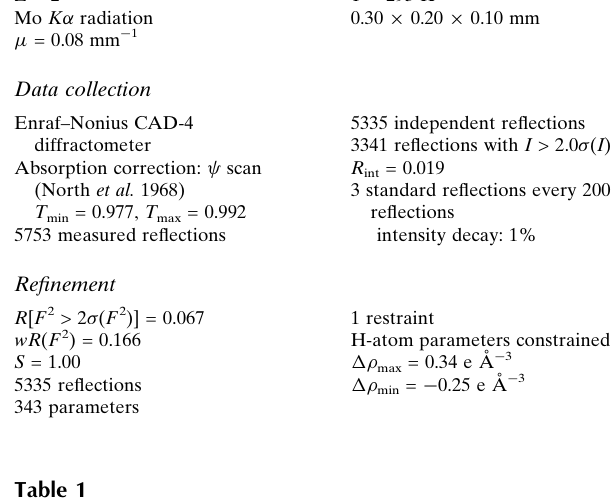
Hydrogen-bond geometry (A˚ , (cid:3)